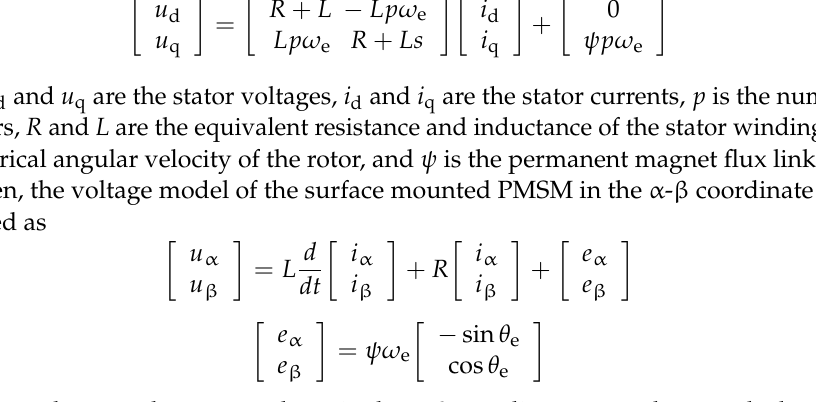
where u α and u β are the stator voltage in the α - β coordinate, e α and e β are the back EMF, i β and i β are the stator current, and θ e is the electrical angle of the rotor position. The mechanical equation of the PMSM is as follows: